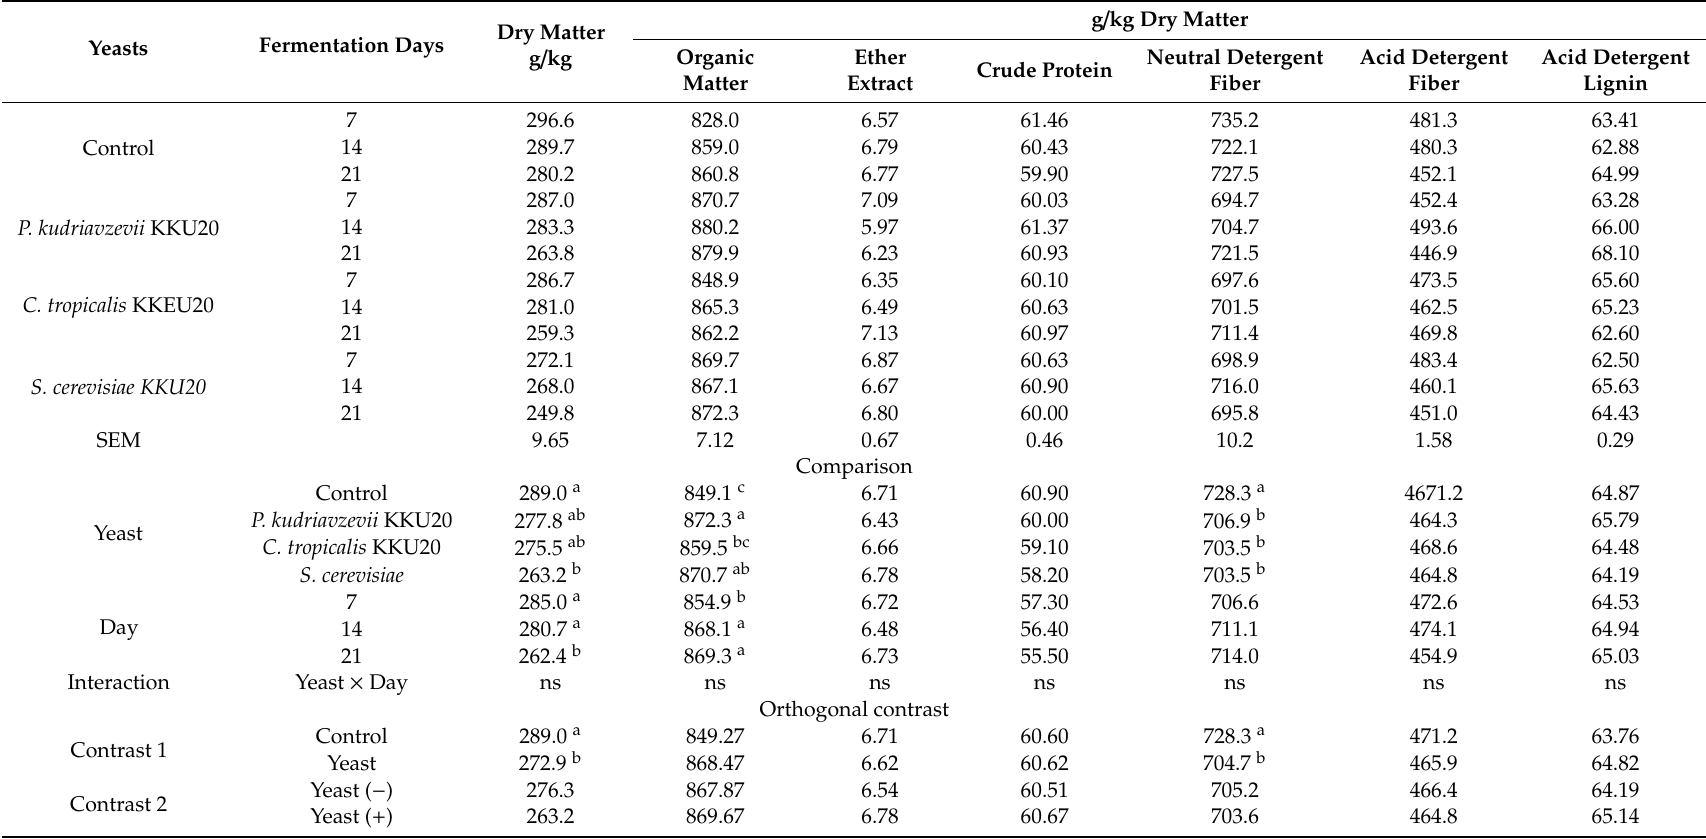
Table 1. Chemical composition (g / kg) rice straw fermented with Crabtree-positive and -negative yeasts (DM